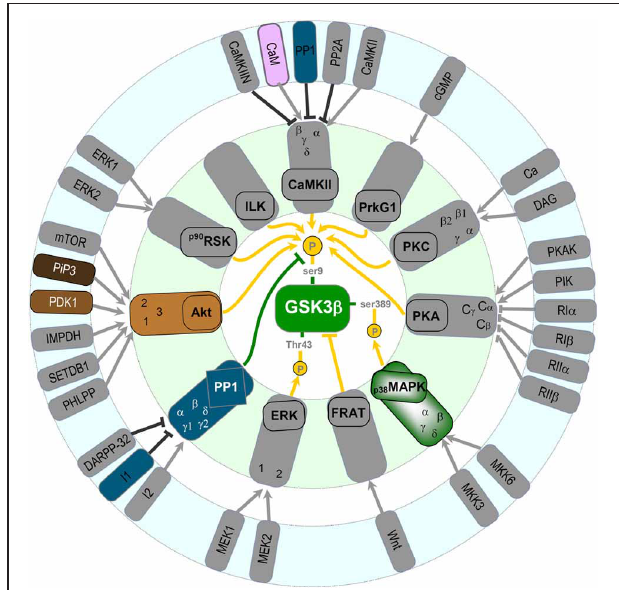
FIGURE 3 | Potential regulators of GSK-3 β in neurons (see text for